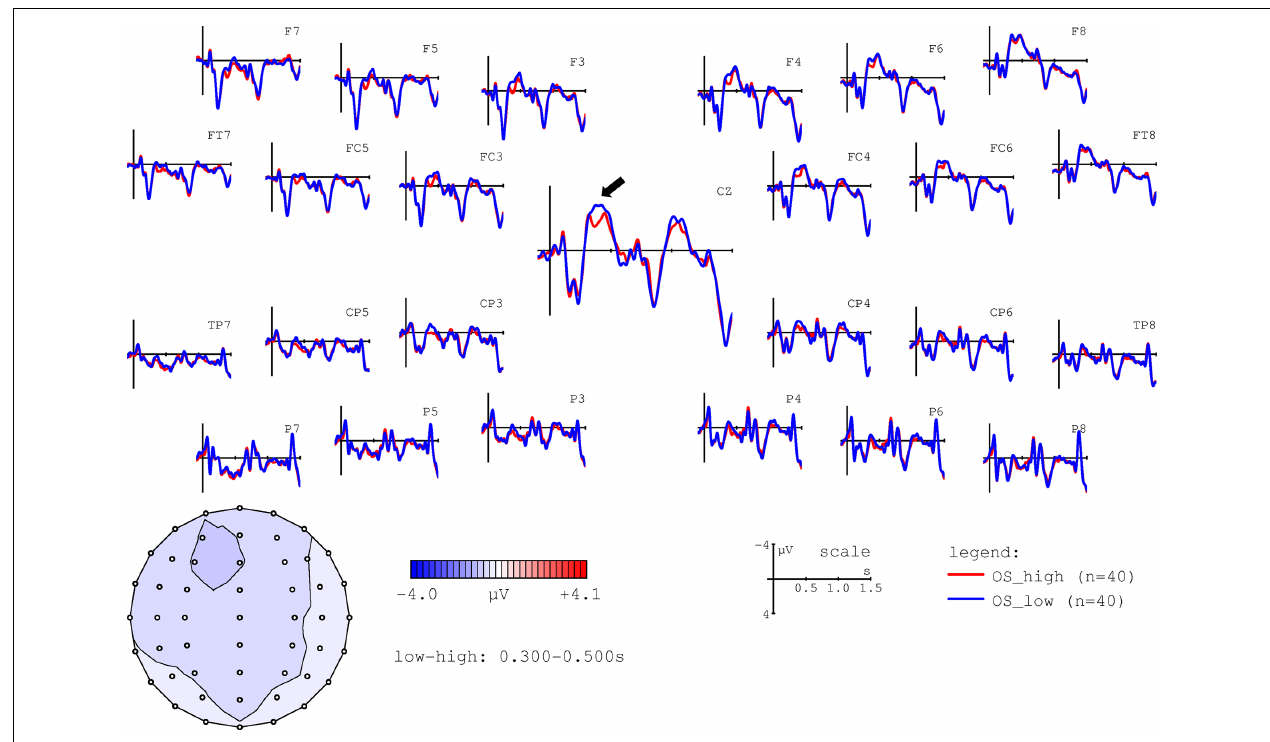
FIGURE 4 | Grand average ERPs time-locked to the second NP (onset at the vertical bar) for high (red line) and lowACT (blue line) nouns in object-initial sentences. Negativity is plotted upward.The voltage map shows the topography of the effect (amplitudes for low – high ACT nouns in the 300–500 ms time